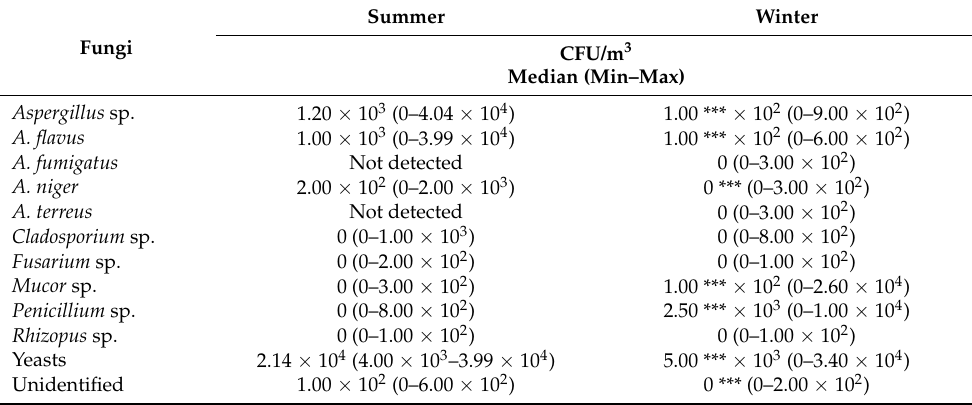
Table 5. Composition of airborne fungal flora in broiler house during five-week fattening in summer and